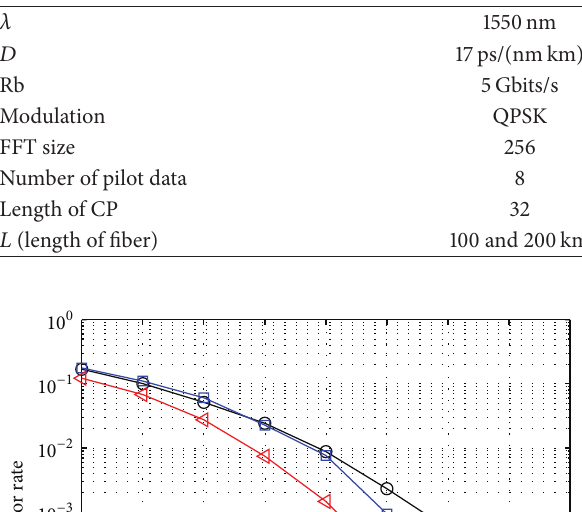
Table 1: Simulation parameters.